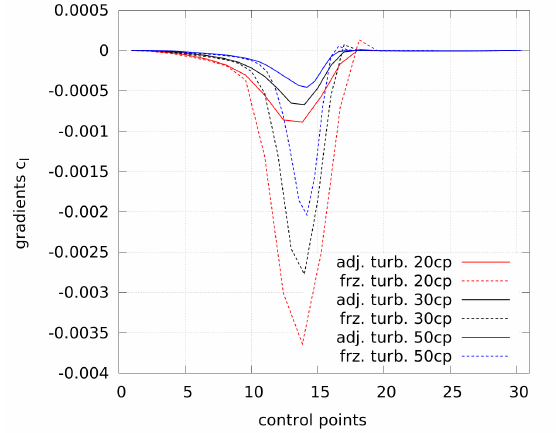
Figure 11. Gradients of the first optimization step for an increase in lift by 2% at AoA = 12 ◦ . Frozen as well as adjoint turbulence are used. The number of control points is labeled as “XXcp”. The control points start from the trailing edge on the suction side, pass the leading edge, and end at the trailing edge on the pressure